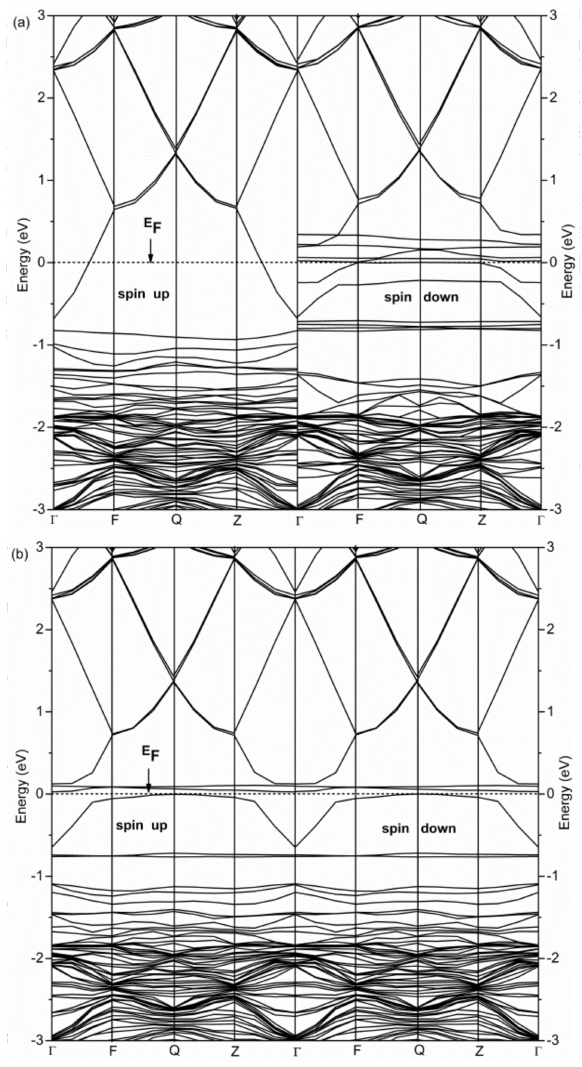
Figure 3. Band structures of Ni-doped ZB ZnO. ( a ) FM; ( b )